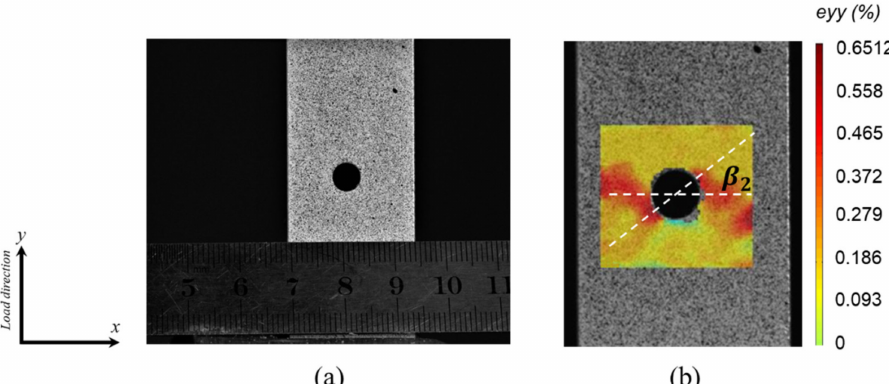
Figure 13. Images of fractured specimens of UACS laminates with bi-angled slits: ( a ) notched UACS laminates, ( b ) unnotched UACS laminates.